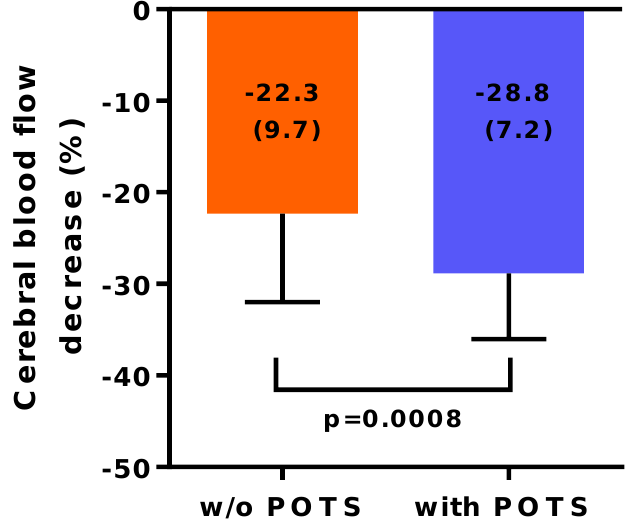
Figure 3. Cerebral blood flow reductions in percent reduction between the supine position and the sitting position in severe ME / CFS patients with ( n = 34) and without ( n = 66) a history of Postural Orthostatic Tachycardia Syndrome (POTS). A history of POTS could result from self-reporting, from the diagnosis with a standing test or a tilt-table test elsewhere in the past, or by tilt-table testing in our clinic in the past. POTS: postural orthostatic tachycardia syndrome; w / o: without. ME / CFS: myalgic encephalomyelitis / chronic fatigue syndrome; p -values shown are the result from an unpaired t-test. Results are presented as percentage cerebral blood flow decrease (standard deviation).